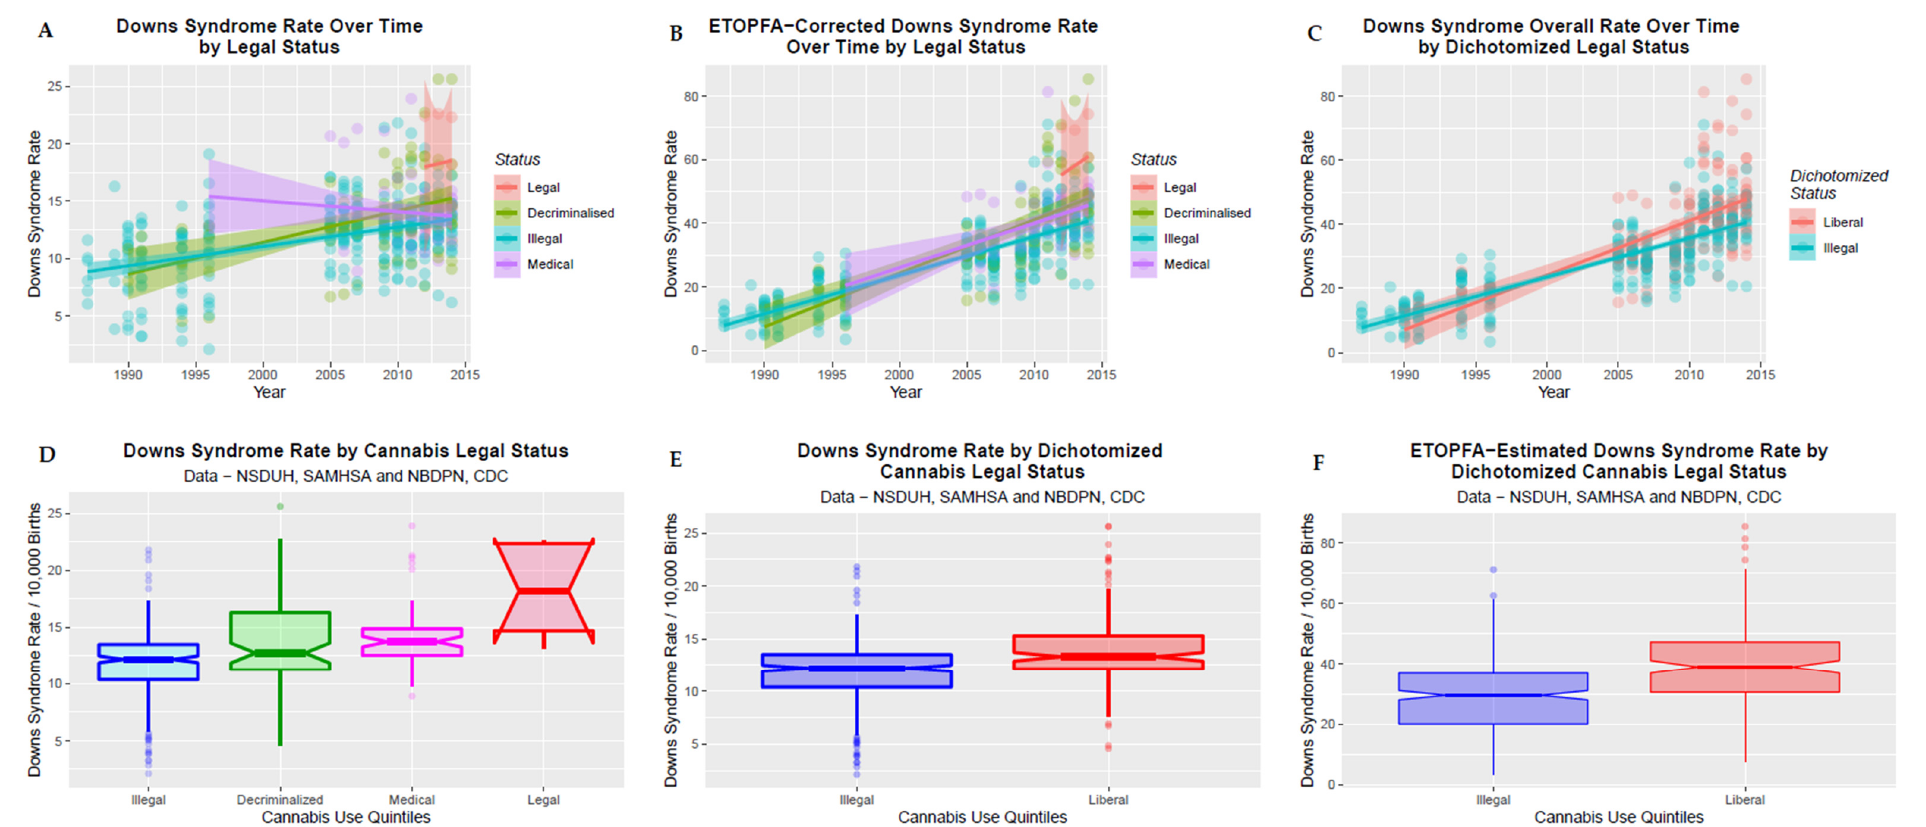
Figure 5. Effect of legal status on DSR. ( A ) DS over time by legal status. ( B ) ETOPFA-corrected estimates of DSR over time by legal status. ( C ) DSR over time by dichotomized legal status. The three regimes representing relaxed cannabis laws are collapsed into the “liberal” category. ( D ) Boxplot of DSR by cannabis legal status. Note that non-overlapping notches signifies statistical significance. ( E ) DSR by dichotomized cannabis legal status. ( F ) ETOPFA-corrected DSR by dichotomized legal status.